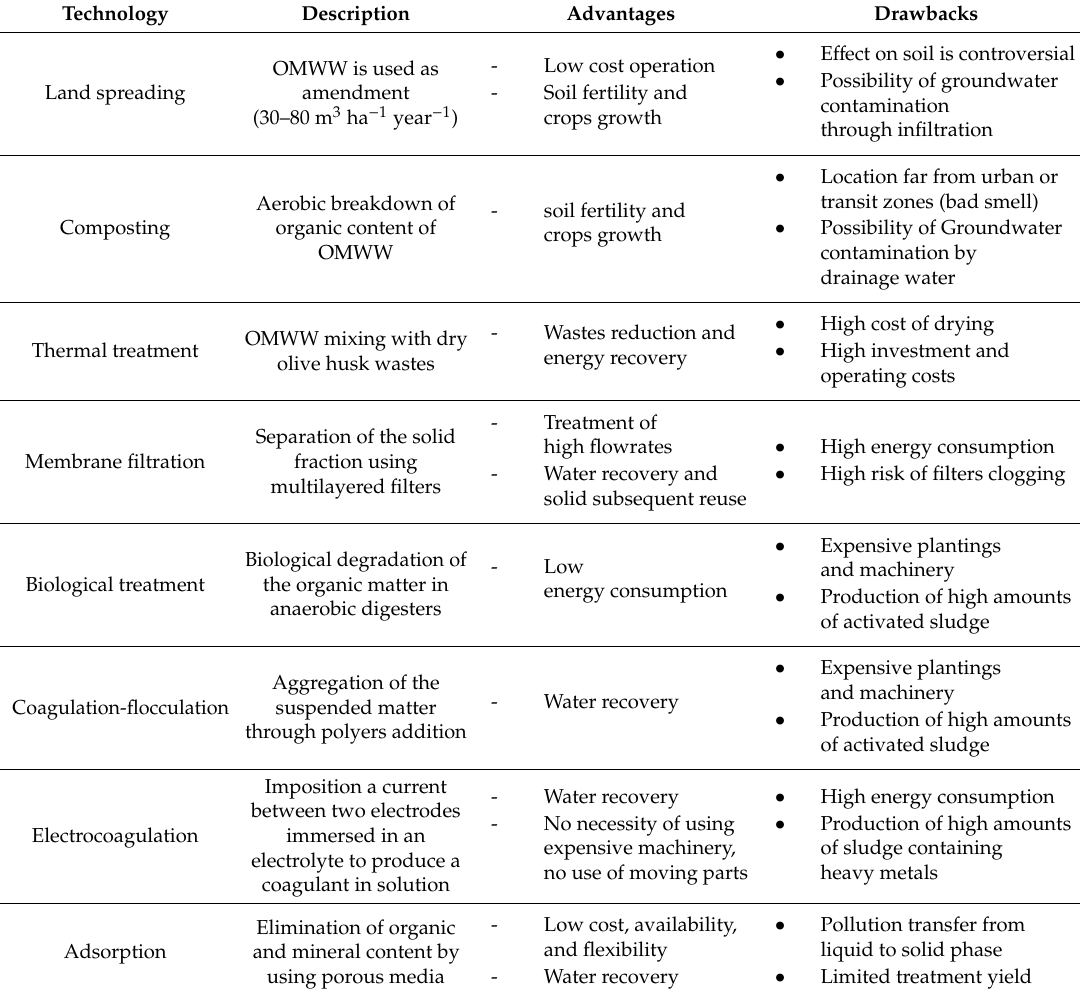
Table 1. Main applied technologies for OMWW